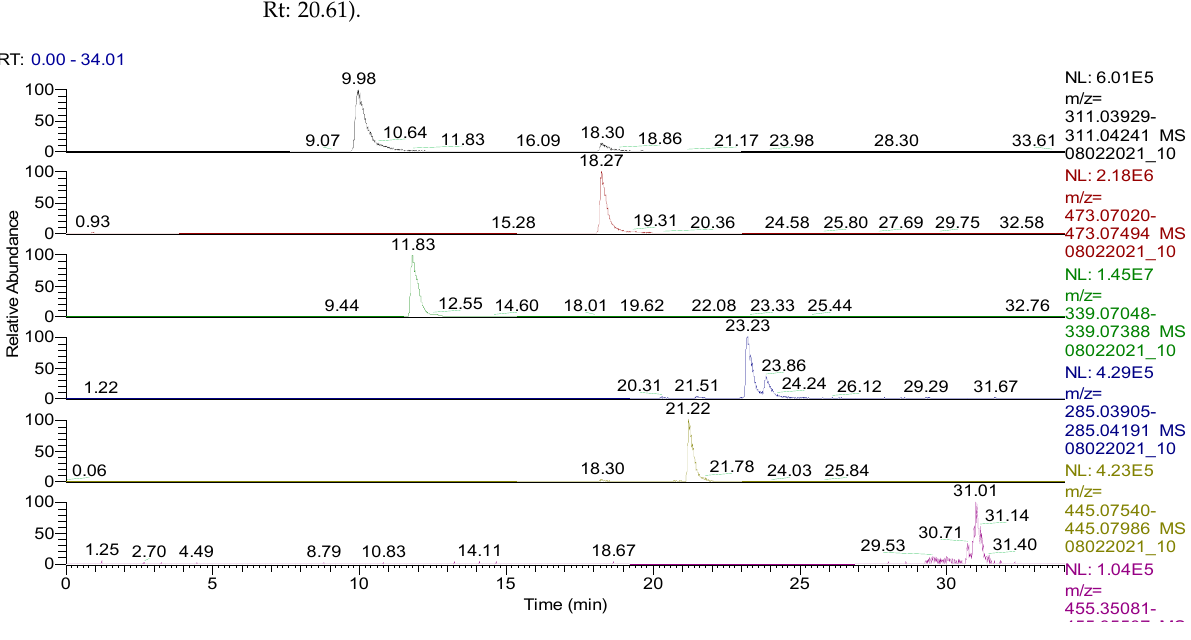
Figure 5. UHPLC–HRMS/MS chromatogram for CHE in which were identified (top to bottom): caftaric acid ( m/z : 311.04085, Rt: 9.98), chicoric acid ( m/z : 473.07257, Rt: 18.27), cichorin ( m/z : 339.07218, Rt: 11.83), luteolin ( m/z : 285.04048, Rt: 23.23/23.86), apigenin-7-O-glucuronide ( m/z : 445.07763, Rt: 21.22), oleanolic acid ( m/z : 455.35309, Rt: 31.01).